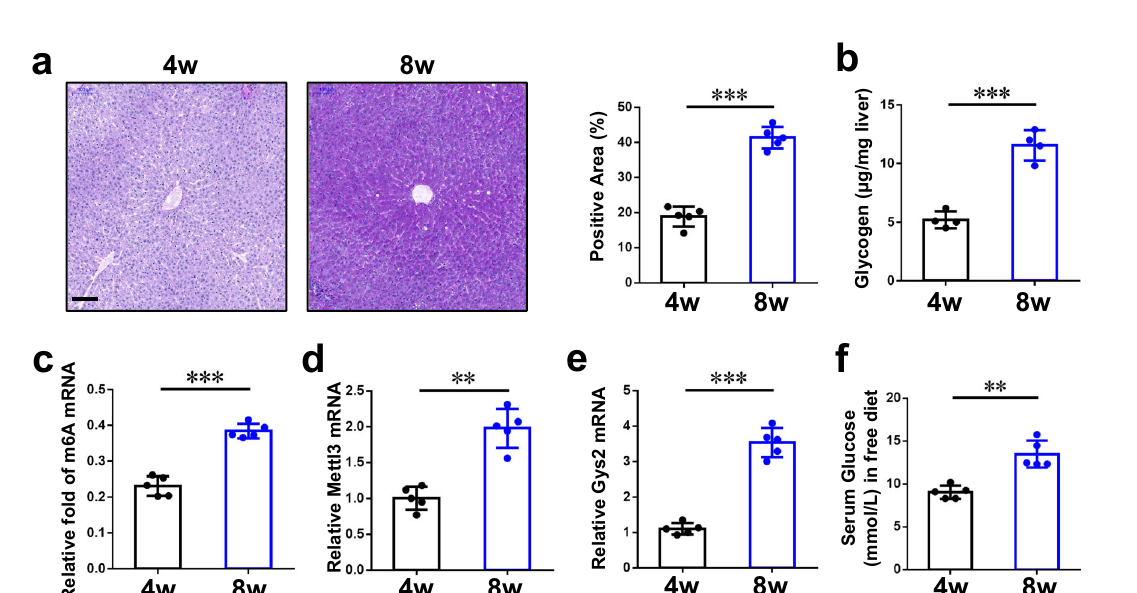
Fig. 5 | Hepatic Gys2 overexpression alleviated glycogen shortage caused by Mettl3 knockout. a , b Western blotting assay ( a ) and IHC staining ( b ) reveal the effect of reconstitution of GYS2. Luc, Luciferase. For fi gure b , bar = 50 μ m. n =5 animals. Data are presented as mean values+/ − SEM. One-way ANOVA was per- formed to determine a difference between columns. *** p <0.001. c – e Hepatic glycogen content assay ( c ) PAS staining ( d ) and transmission electron microscope pictures( e )ofmouseliverswithindicatedgenotypesandaluciferase(Luc)orGys2- overexpressing adeno-associated virus (AAV). Bar: 50 μ m ( d ), 0.5 μ m ( e ). n ≥ 4 animals. Data are presented as mean values+/ − SEM. One-way ANOVA was per- formed to determine a difference between columns in fi gure ( c ) and ( d ).